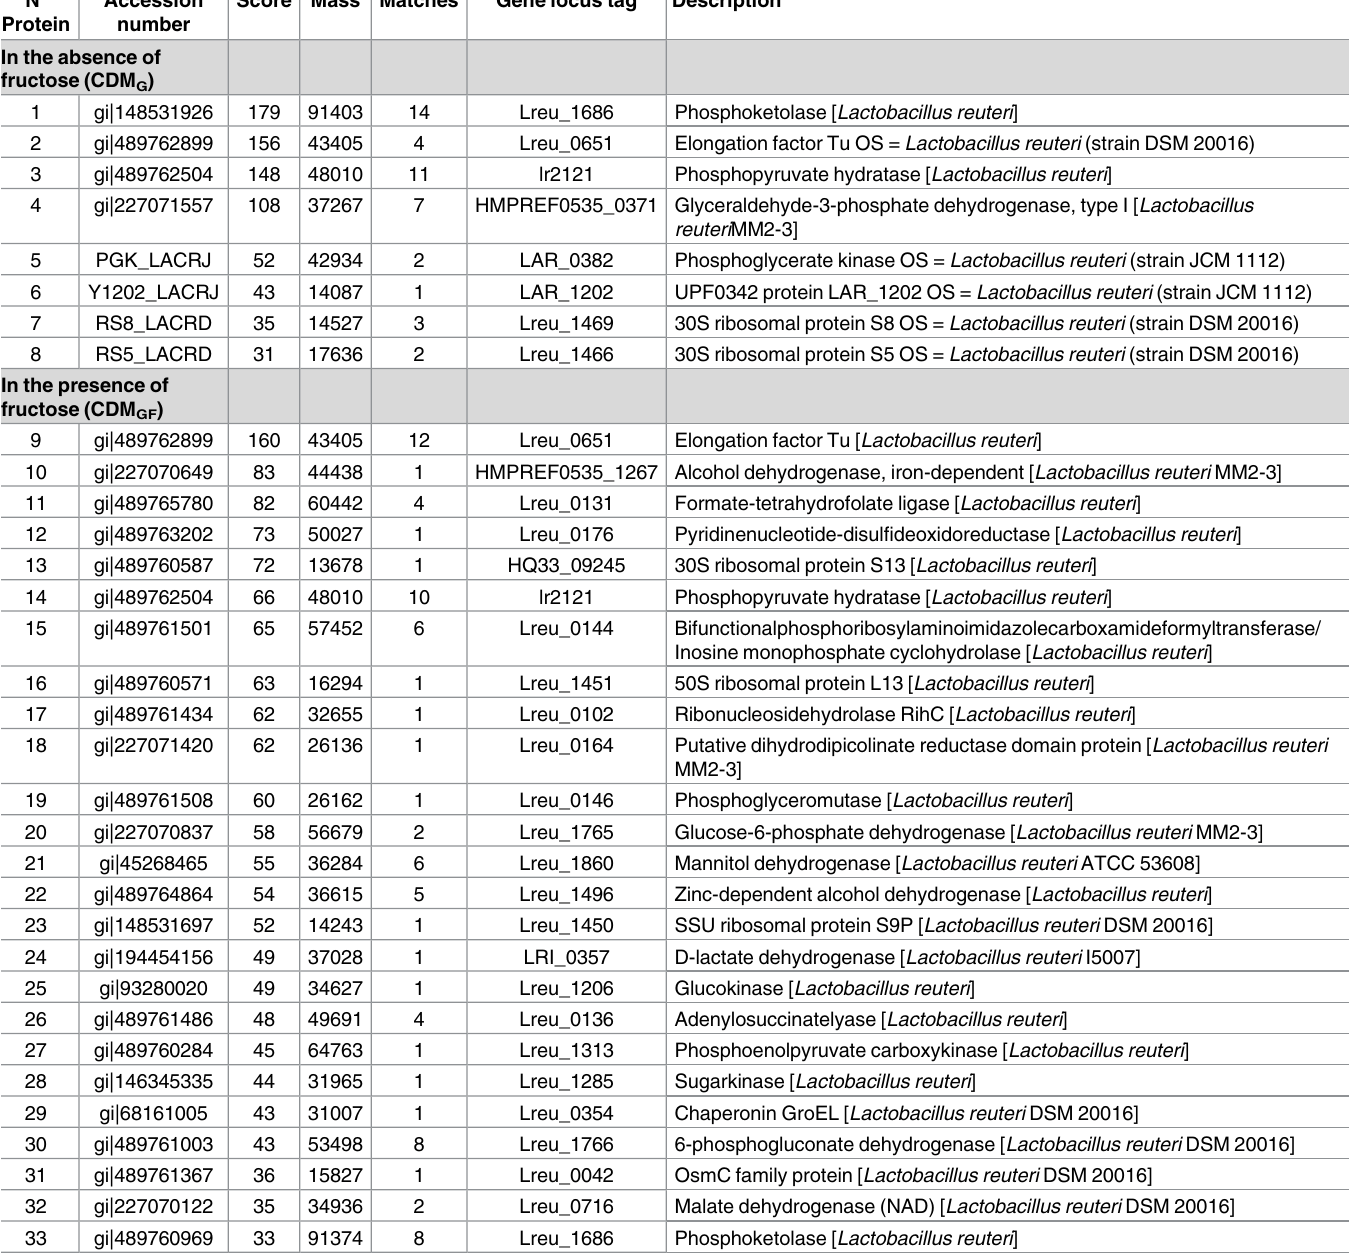
Table 2. Shotgun proteomic identification of proteins of L . reuteri CRL 1101 whole lysates,grown in the absence and in the presenceof fructose for 24 h. Score and mass values are reportedalong with the number of identifiedpeptides (matches) and gene locus tag. In the current experimental condi- tions, matches with score values > 30 were considered proof of identity or extensive homology ( p <